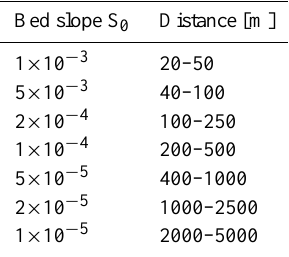
Table 1. Estimated reach length as a function of the river bed